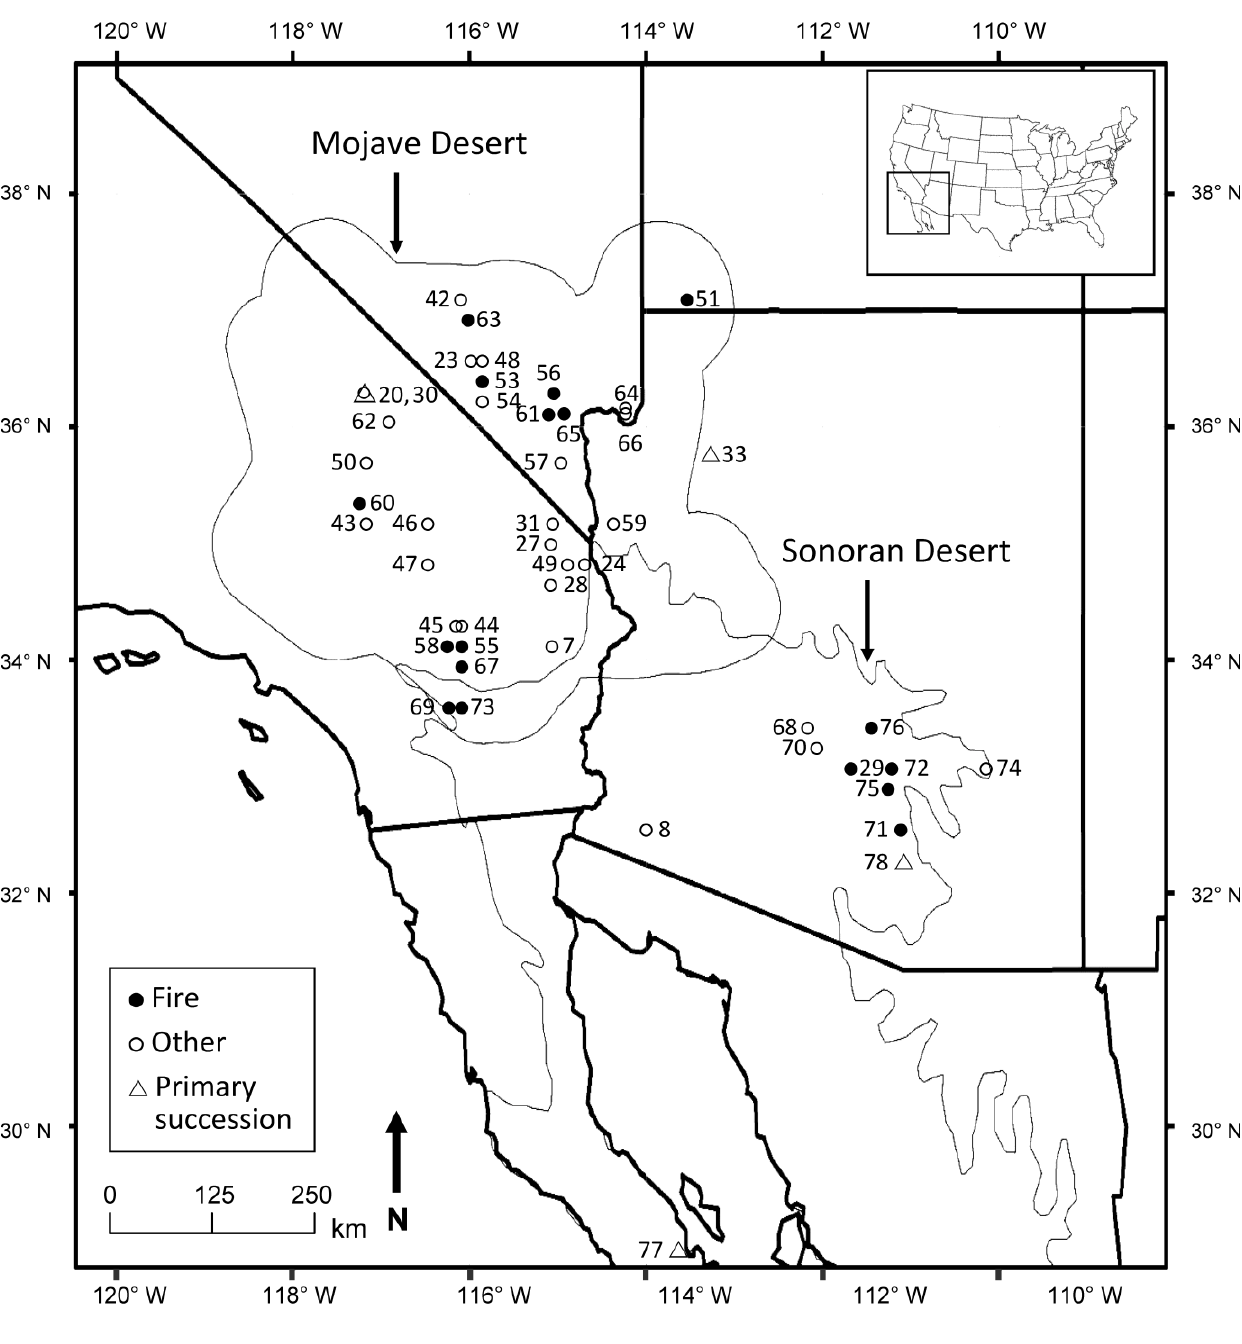
Figure 2. Location of 47 studies meeting selection criteria for a quantitative analysis of plant recovery and succession in the Mojave and Sonoran Deserts of the American Southwest. Studies are distinguished by disturbance type (fire or land-clearing disturbances such as roads) and are numbered according to the Appendix and References